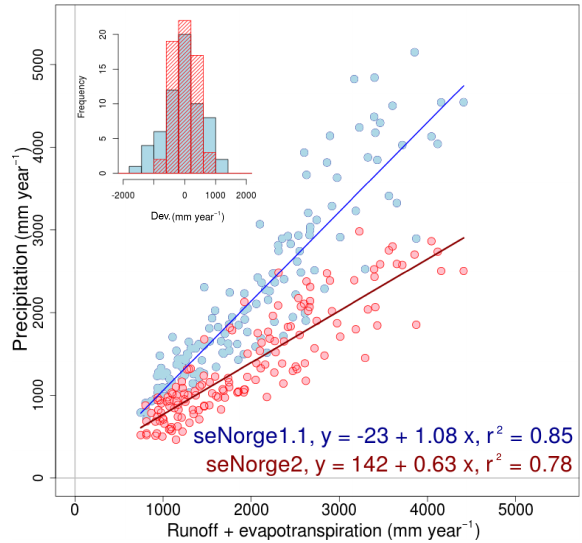
Figure 5. Average yearly precipitation (inputs of water to the catch- ment) against the sum of average yearly runoff and actual evapo- transpiration (losses of water from the catchment) for the period from 1 January 2000 to 31 December 2013 for seNorge1.1 (blue) and seNorge2 (red). The upper left box shows the distribution of regression residuals when the sum of runoff and actual evapotran- spiration exceeds 2000mmyr − 1